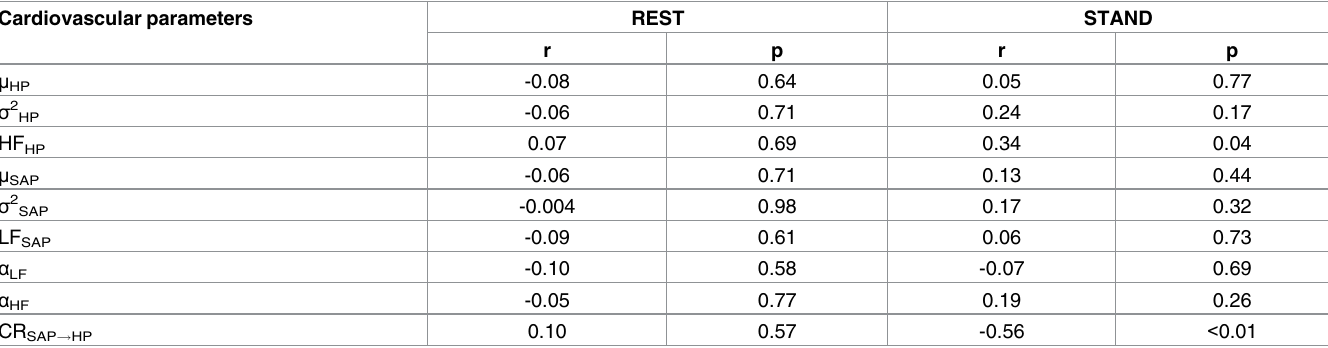
Table 2. Linear correlation analysis of the cardiovascular control parameters on the FIQ score at REST and during STAND. Cardiovascular parameters REST